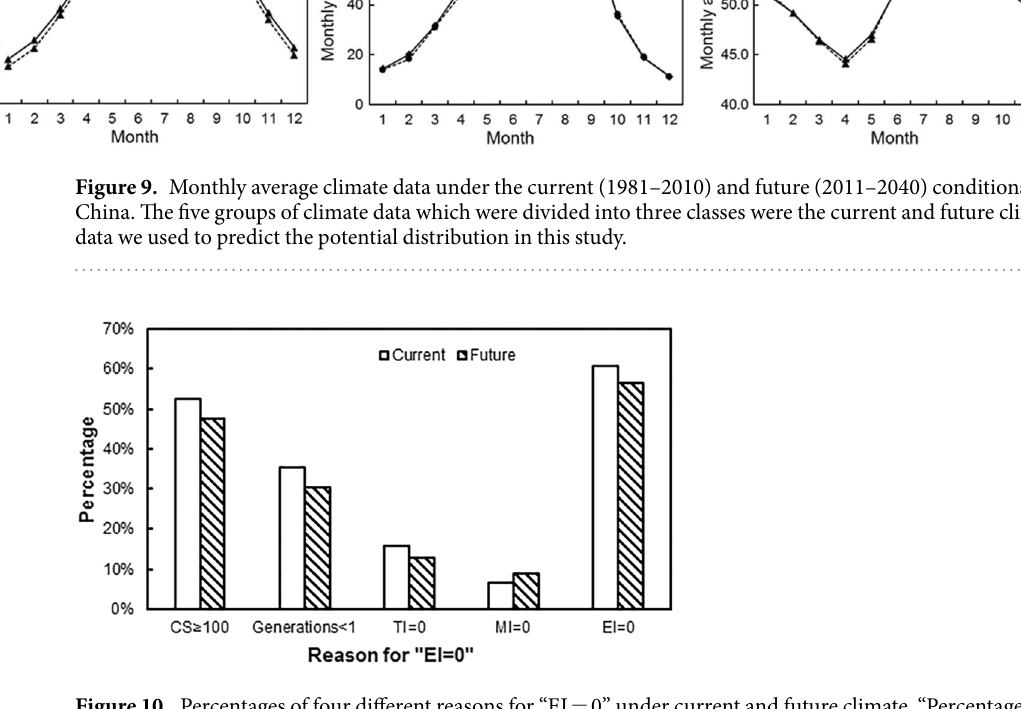
length; thus, the number of regions where the accumulated temperature can no longer support the completion of the development of one generation (generations < 1) will decrease. Temperature increases in the winter will reduce CS, and the number of regions that are unsuitable as habitats because of cold stress will decrease. In addi- tion, increases in temperature and precipitation will increase the Temperature Index and Moisture Index in the regions and lead to fewer regions with TI or MI equal to zero. These results also show that temperature is the most important meteorological factor affecting insect distribution. Non-climatic factors, which are not included in CLIMEX, can also affect species distribution, such as natural enemies, topography, and host distribution. Among them, host distribution is one of the most important factors influencing a pest’s potential distribution, because hosts are a necessary condition for pest survival. However, the host trees of E. fornicates are diverse and include Heavea brasiliensis , Ricinus communis , Robinia pseudoacacia , Cassia siamea , Platanus acerifolia , Acer negundo , Acacia sp., Cinnamomum spp., Populus spp., Quercus spp., and Salix spp., Over 100 species 21 are found in China. Most of these plants are mainly located in southern China, while Populus spp. and Salix spp. are widely distributed. Nevertheless, E. fornicates is very resilient and may change its feeding preferences with changes in climate. Thus, its distribution may not be limited by the distribution of its hosts. Based on geographic differences in environmental and socioeconomic characteristics, China could be divided into four areas: South Region, North Region, Northwest Region and Qinghai-Tibet Region (Fig. 11). The Daxing’an-Yinshan-Helan Mountains (boundary A) divided north and northwest regions approximately by the 400 mm isohyet. The Qinling-Huaihe boundary line (boundary B) is the boundary of the South Region and North Region, mainly determined by climate, which is overlap with isothermal line of 0 °C in January and 800 mm isohyet. The Kunlun-Qilian-Hengduan Mountains (boundary C) form the boundary that separates the Qinghai-Tibet Region from the other three regions, mainly divided by terrain. Most of the determined factors